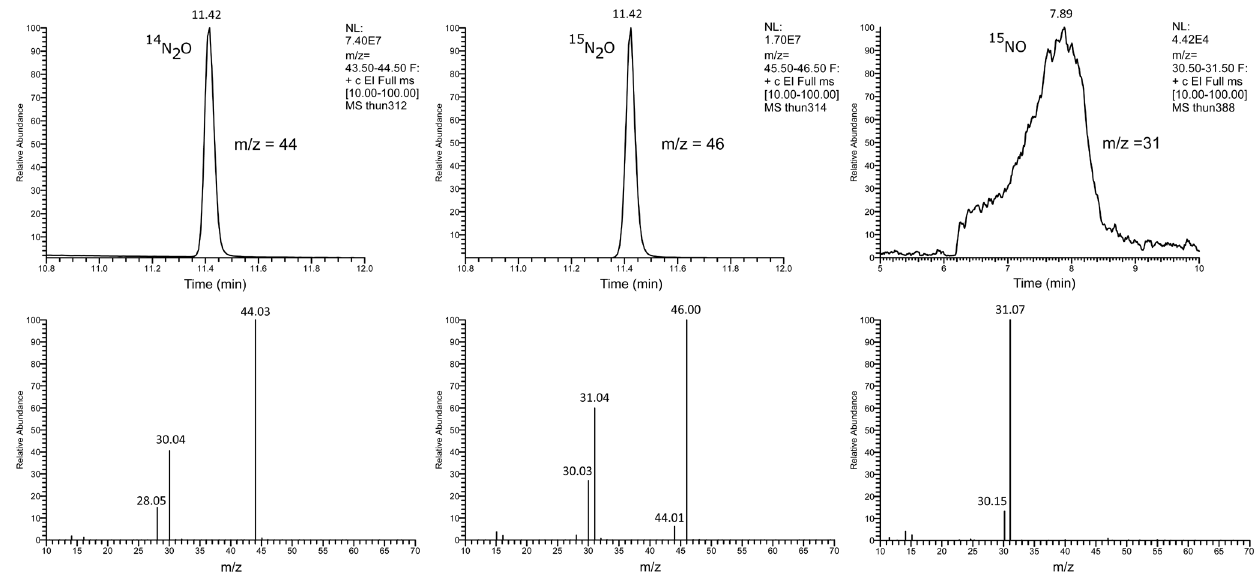
Figure 2. Chromatograms and mass spectra of native 14 N